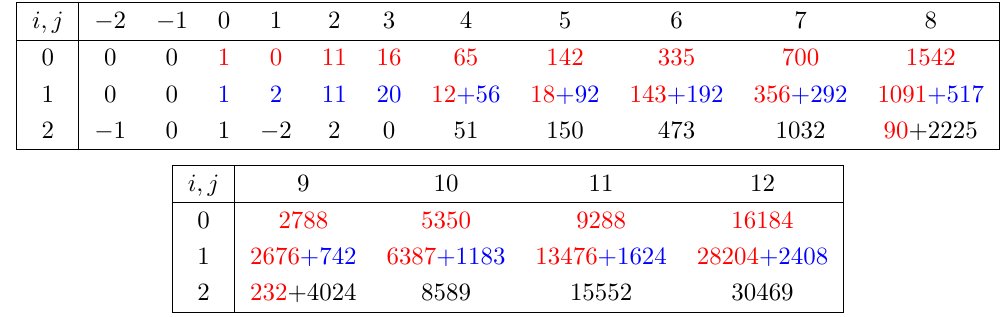
for the elliptic genus of two SU(3) instanton i;j